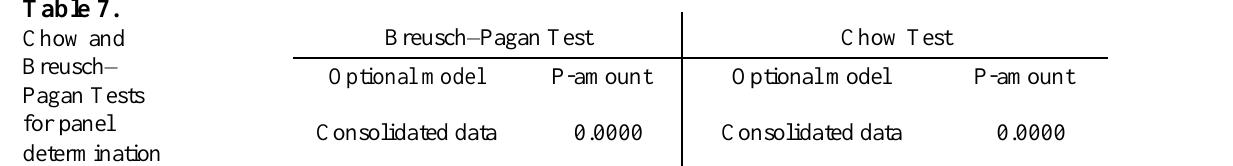
Breusch–Pagan Test Chow Test Chow and